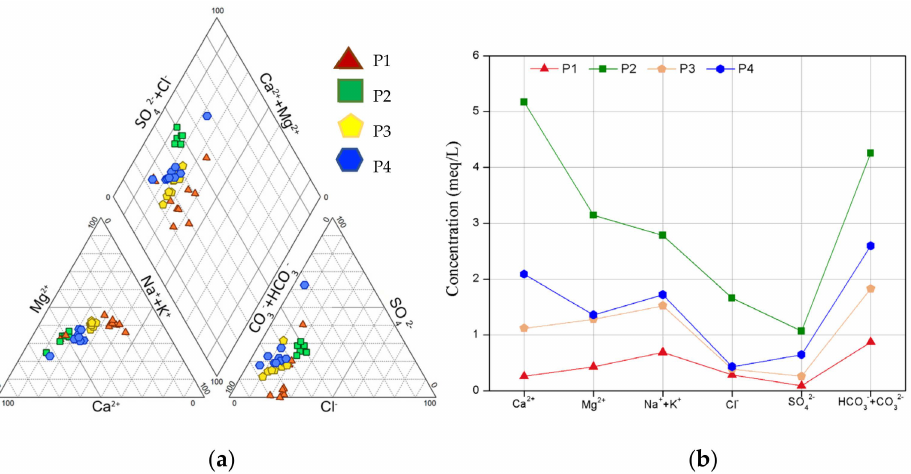
Figure 11. Piper ( a ), and Schoeller ( b ) diagrams for groundwater chemistry composition at P1 ( ), P2 ( ), P3 ( ) y P4 ( ).